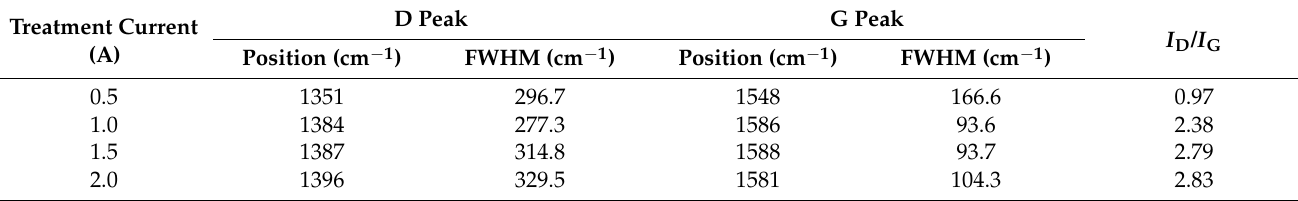
Table 3. The position and FHWM of D peak and G peak, as well as the I D / I G ratio values of UHMWPE substrates treated with different carbon plasma currents.